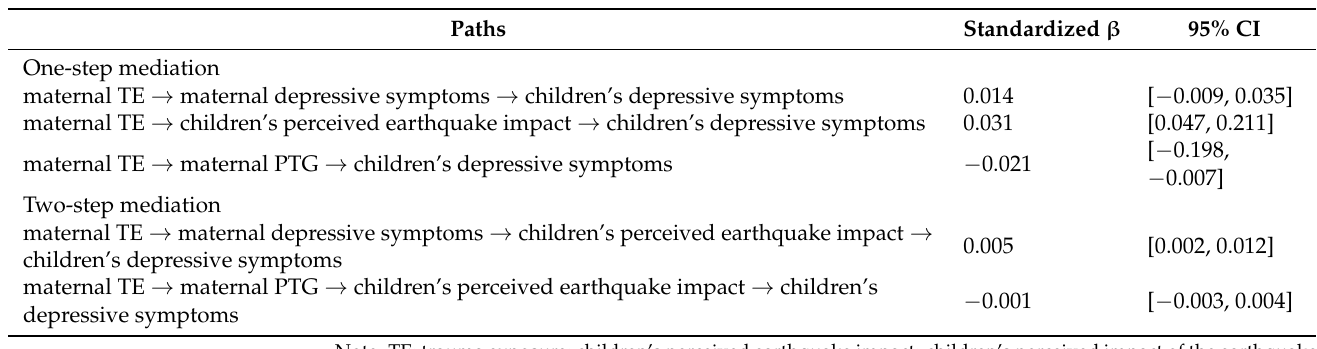
Table 3. Standardized regression coefficients and 95% confidence intervals (CIs) for the indirect